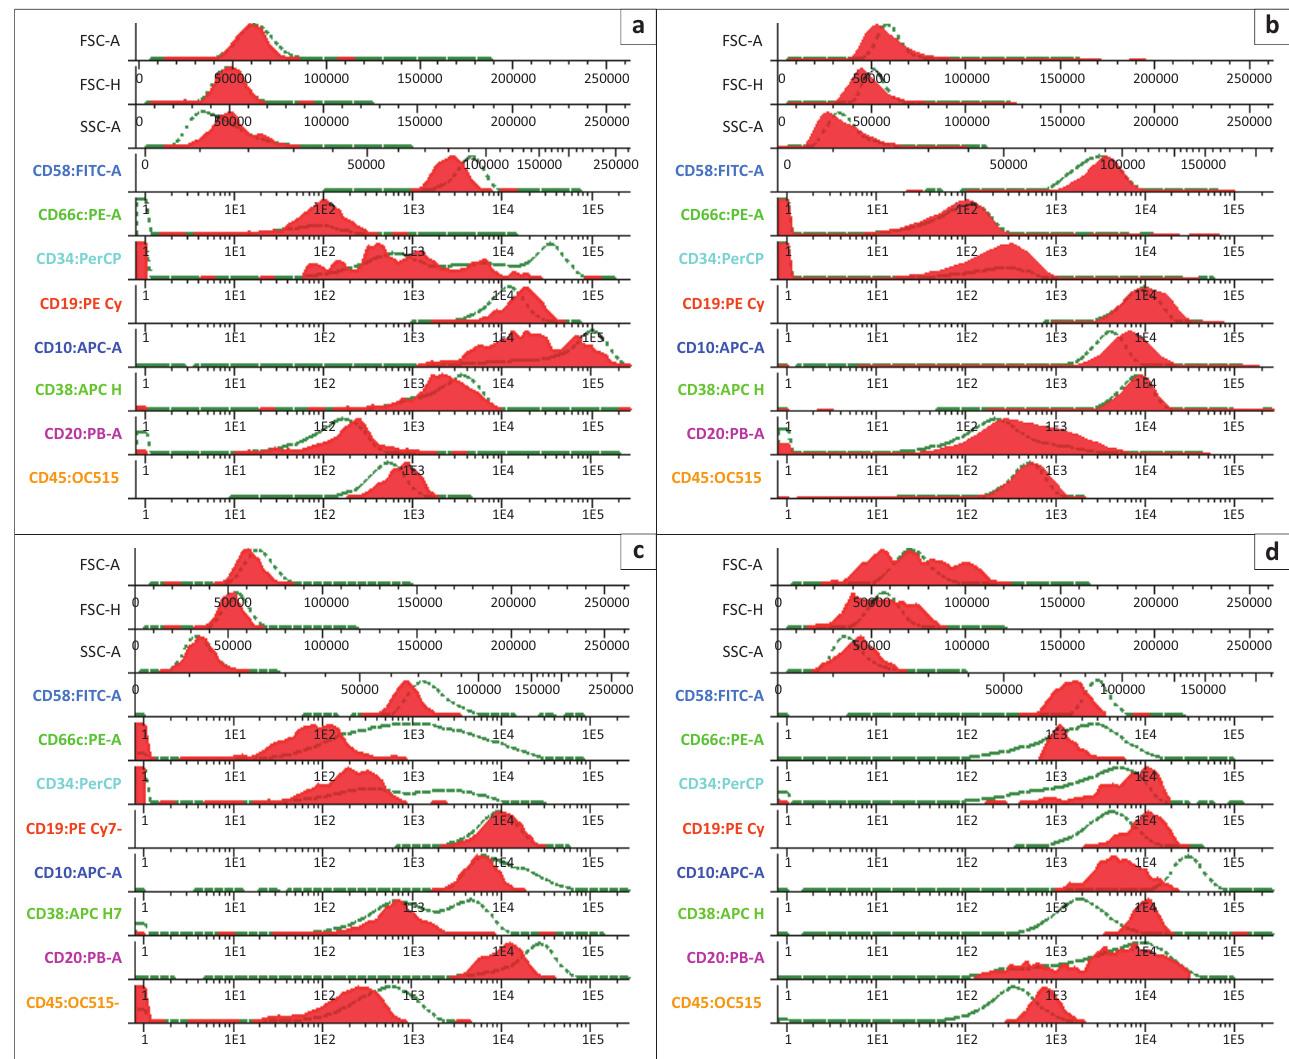
FIGURE 3: Histograms illustrating patients with flow minimal residual disease positivity. (a) flow MRD pos: t (12;21) pos; (b) flow MRD pos: t (1;19) pos; (c) flow MRD pos: hyperdiploidy; (d) flow MRD pos: hyperdiploidy; (e) flow MRD pos: t (1;19) pos; (f) flow MRD pos: hyperdiploidy with antigenic shifts; (g) flow MRD positive (monoclonal IgH).